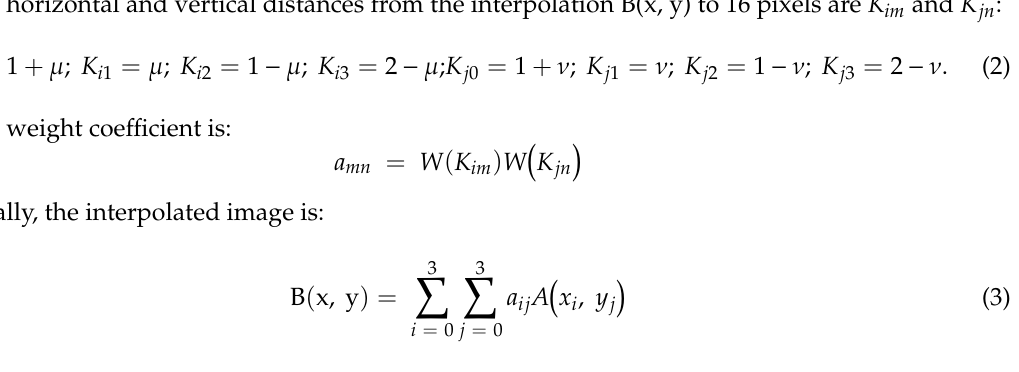
Figure 3. Principle of bicubic interpolation. Figure 4. The CEM spectrum of heavy oil with 19 interpolations in the concentrations range of 1.2 ppm to 625 ppm.